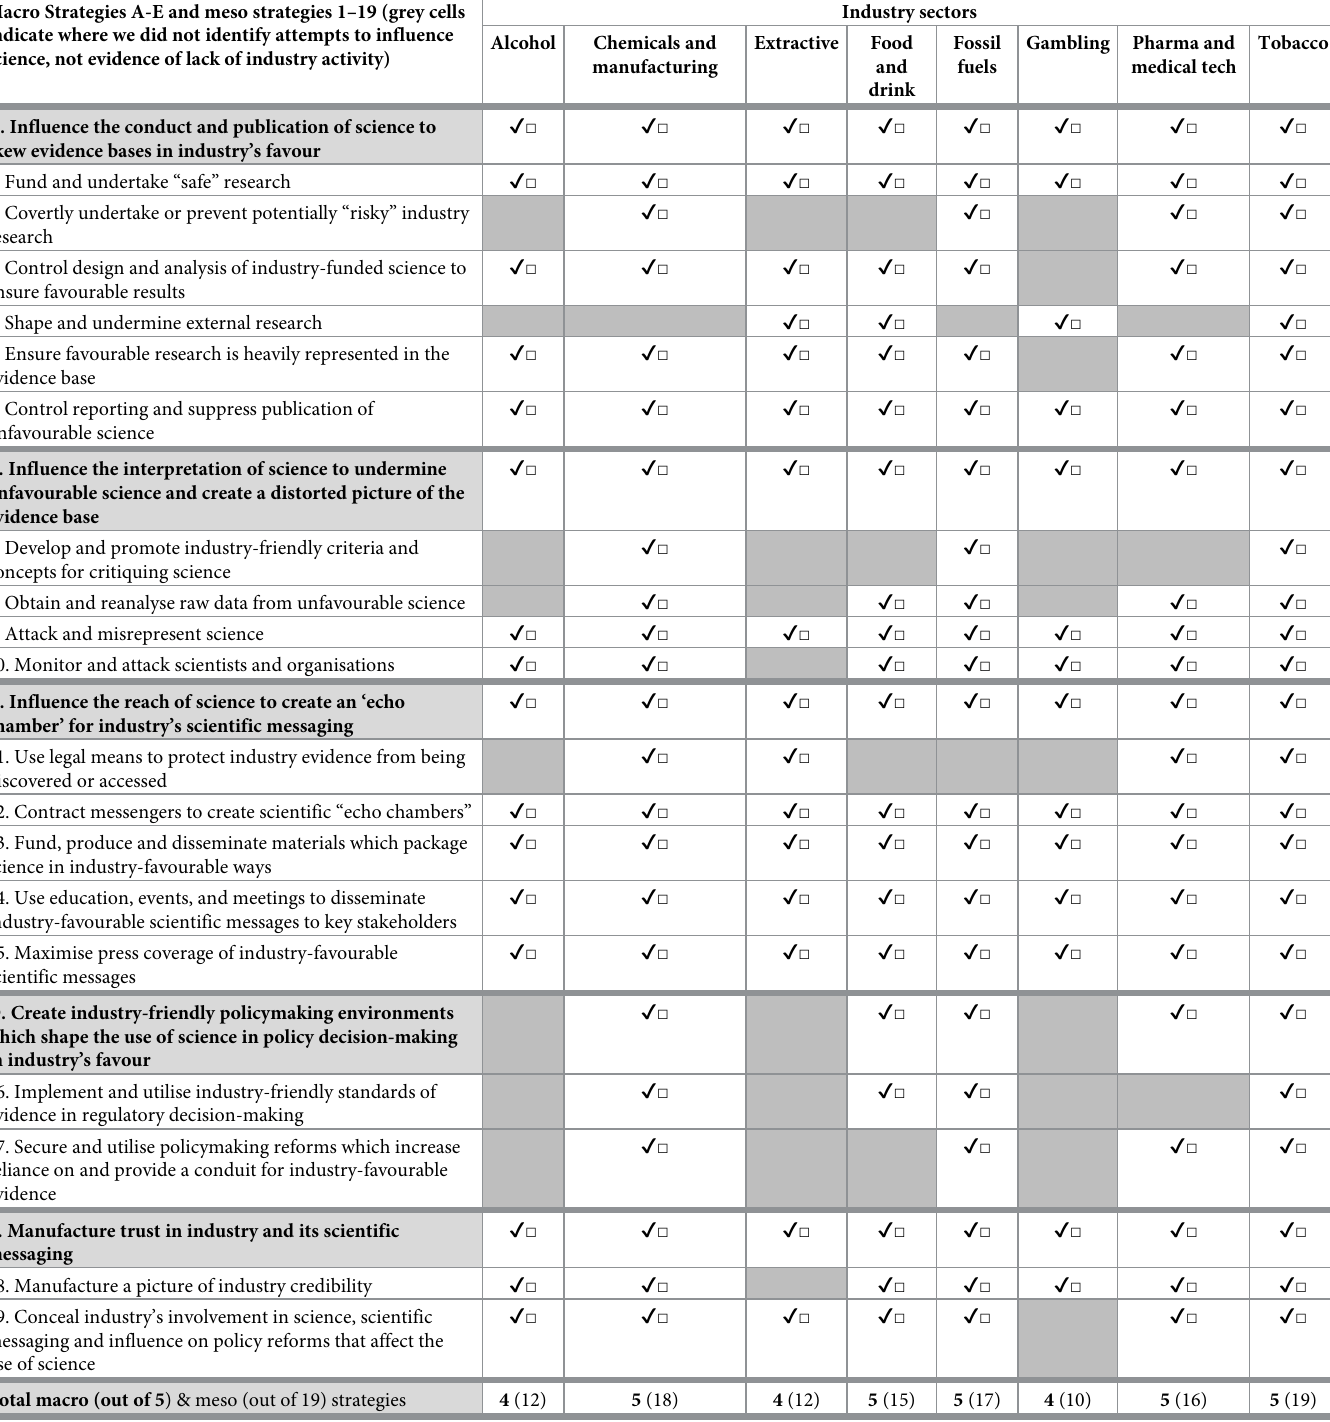
Table 2. Macro and meso strategies used by each sector of industry. Macro Strategies A-E and meso strategies 1–19 (grey cells indicate where we did not identify attempts to